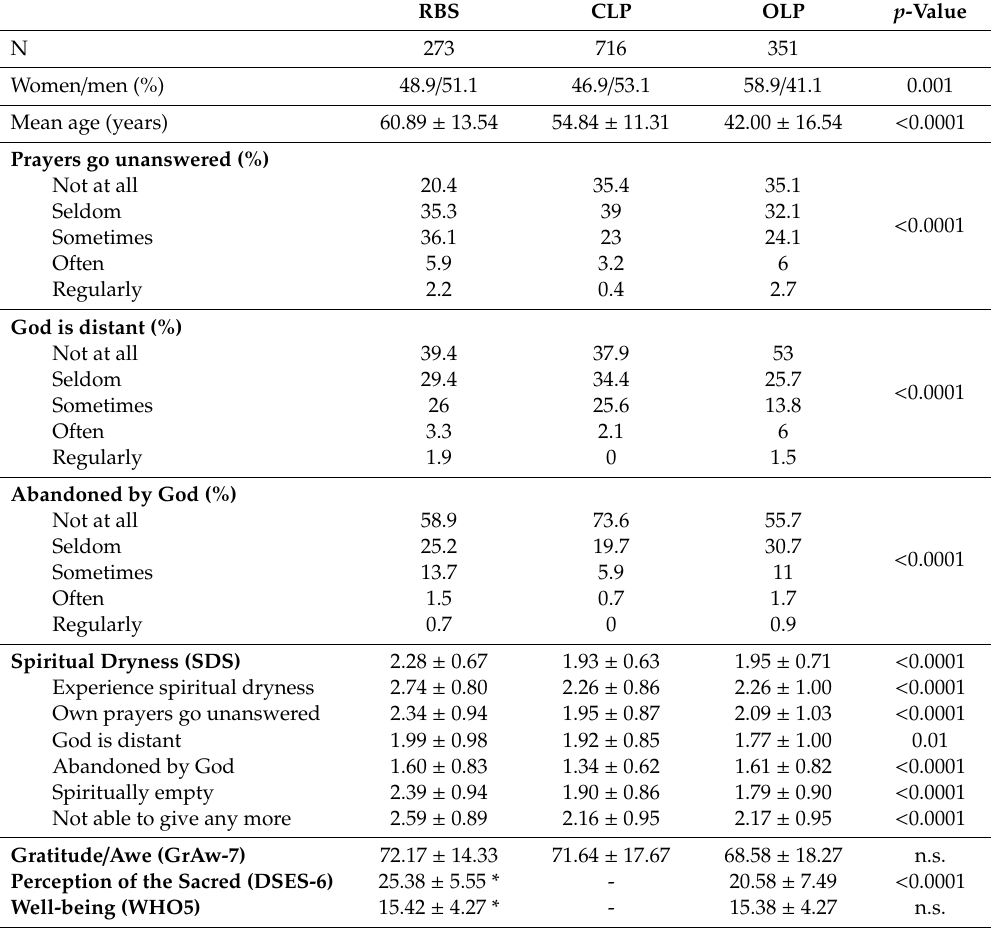
Table 1. Characterization of study persons. RBS: religious brothers and sisters; CLP: Catholic lay people; OLP: other lay people.